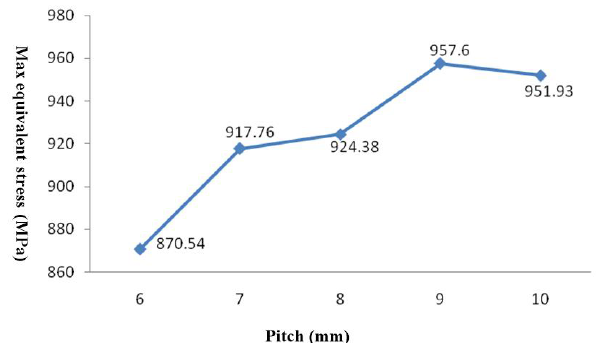
Figure 17. The trend diagram of the maximum equivalent stress of tube body with pitch